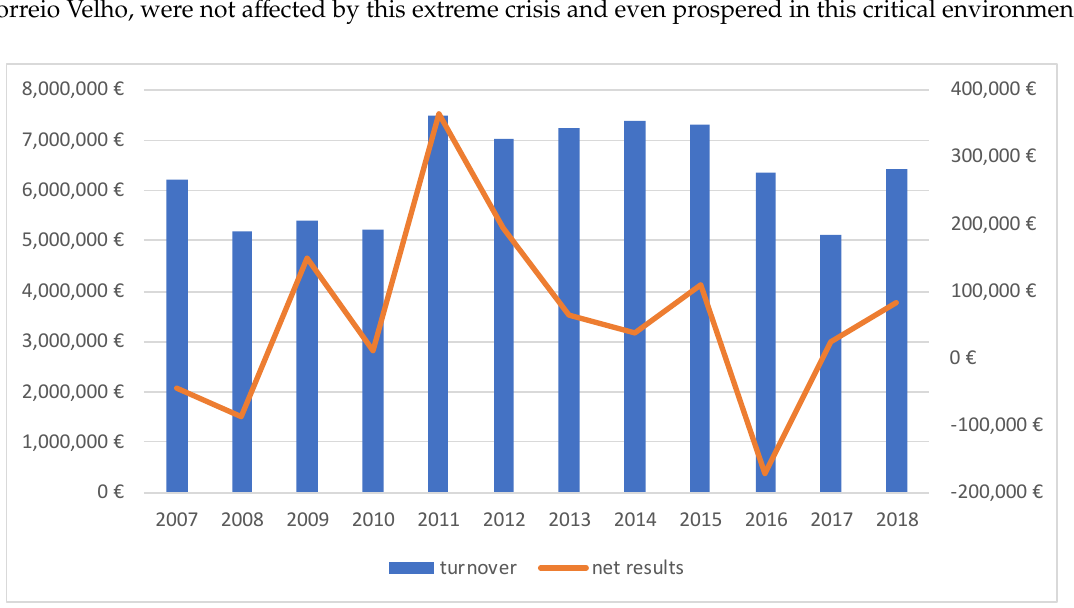
Figure 1. Cabral Moncada Leilões ’ (CML) turnover and net results (2007 – 2018).